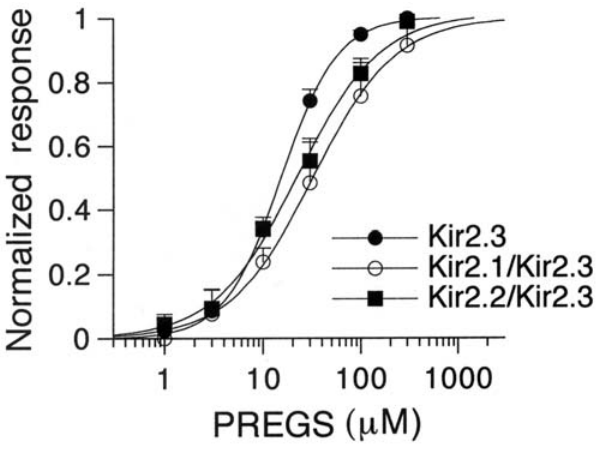
Figure 7. Comparison of the potentiation effects of PREGS on Kir2.3, Kir2.1/Kir2.3, and Kir2.2/Kir2.3 channels expressed in Xenopus oocytes. Responses to PREGS at different concentrations were normalized to the maximal response to PREGS. Current responses were measured at a membrane potential of 2 70 mV. Data are expressed as mean 6